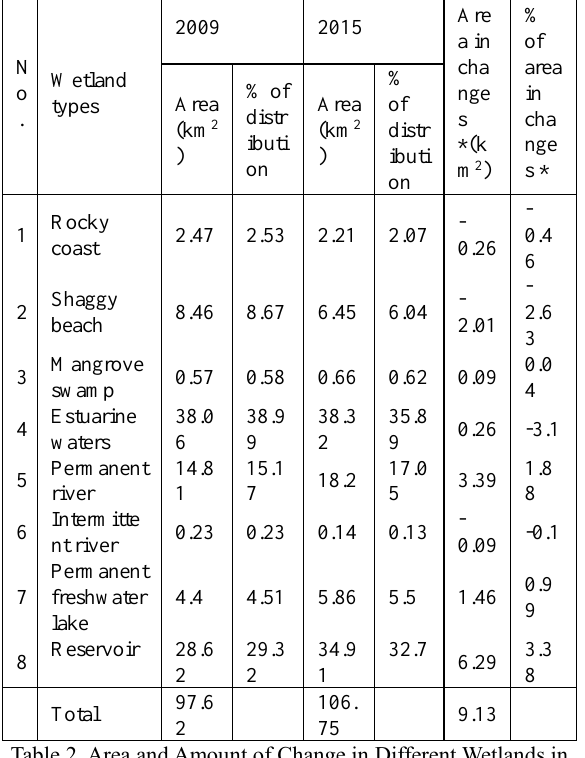
Table 2. Area and Amount of Change in Different Wetlands in the Study Area During 2000–2011.